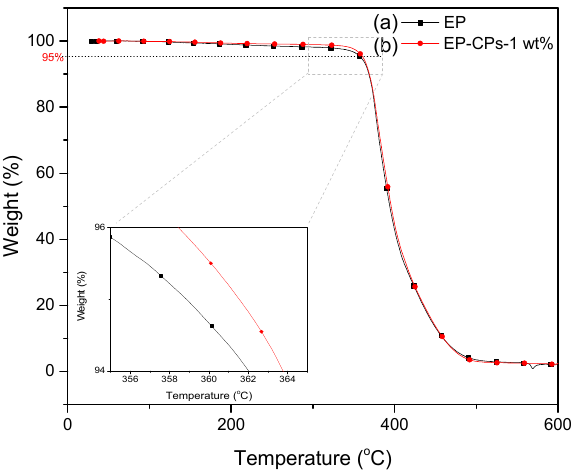
Figure 9. TGA traces of ( a ) EP and ( b ) EP-CPs-1 wt.% materials (heating rate: 10 K.min − 1 ).